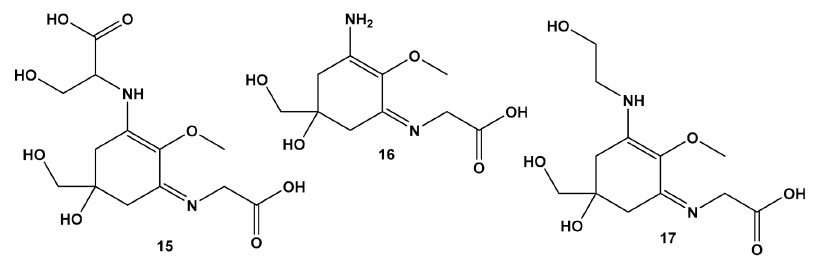
Figure 3. Chemical structure of mycosporine-like amino acids accumulated in A. armata